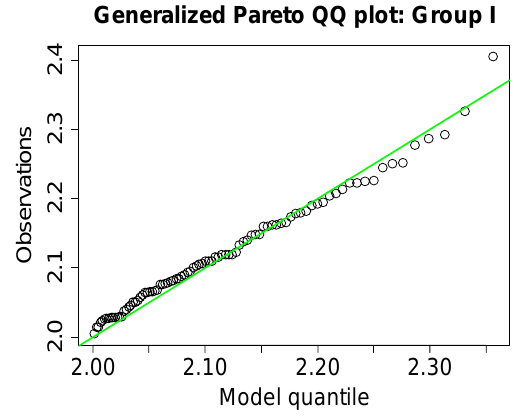
Figure 9. Mean residual life plot for wind waves in Tallinn Bay, Baltic Sea; Group I Fig. 9. Mean residual life plot for wind waves in Tallinn Bay, Baltic Fig. 7. Transformed exponential scale QQ plot of amplification fac- Figure 7. Transformed exponential scale QQ plot of amplification factors based on Generalized Sea; Group I observations. The solid curve represents mean resid- tors based on Generalised Pareto distribution with ln (σ) = α + βH s ; observations. The solid curve represents mean residual life and the dotted curves the Pareto distribution with H βασ += )ln( ; all data. ual life and the dotted curves the approximate pointwise 95% con- all data. s fidence approximate pointwise 95% confidence limits.